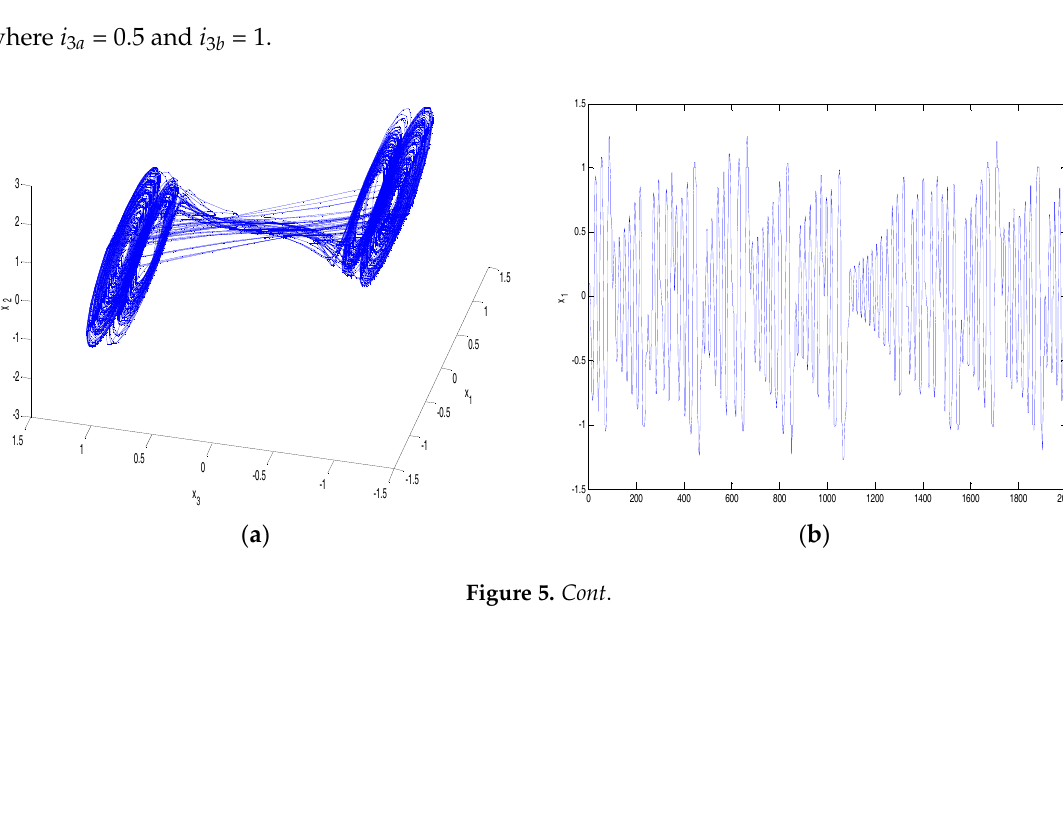
Figure 5. Numerical results of the 1 ‐ D multi ‐ scroll SC ‐ CNN Based system: ( a ) 2 ‐ double scrollin x 1 ‐ x 2 ‐ x 3 plane; ( b ) time response of x 1 (t) dynamic for 2 ‐ double scroll; ( c ) 4 ‐ double scrollin x 1 ‐ x 2 ‐ x 3 plane; and ( d ) time response of x 1 (t) dynamic for 4 ‐ double scroll.